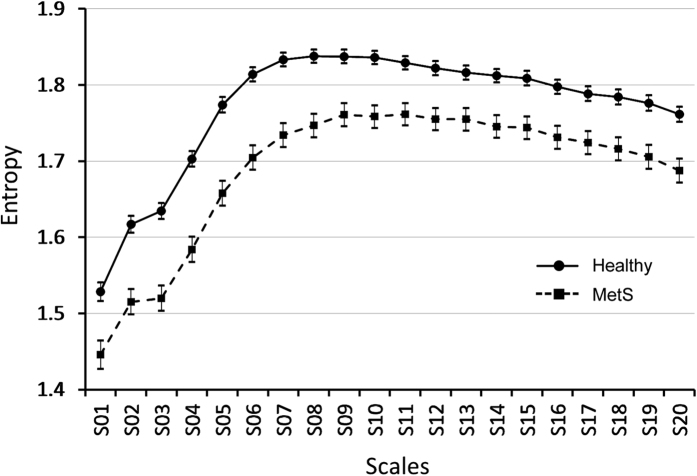
Comparison of MSE (CI1–20) between subjects with metabolic syndrome and healthy subjects.X axis: scale 1–20 of MSE. Y axis: the values of entropy. Data of the healthy and MetS groups are presented as mean ± standard error.